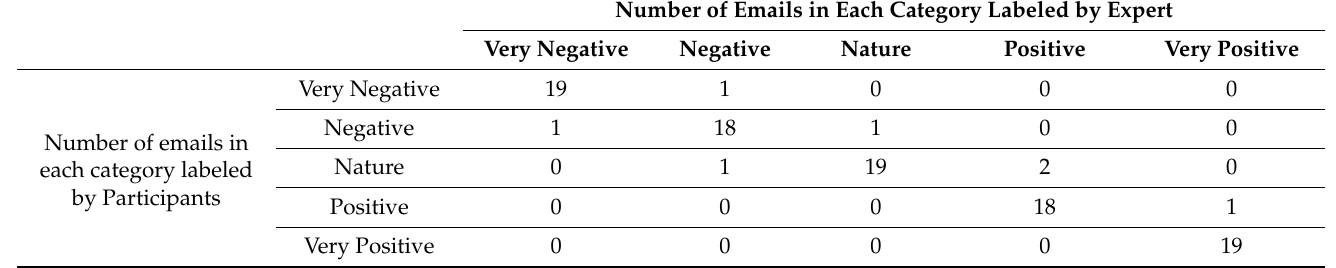
Table 5. Test Result—Labeling emails under proposed